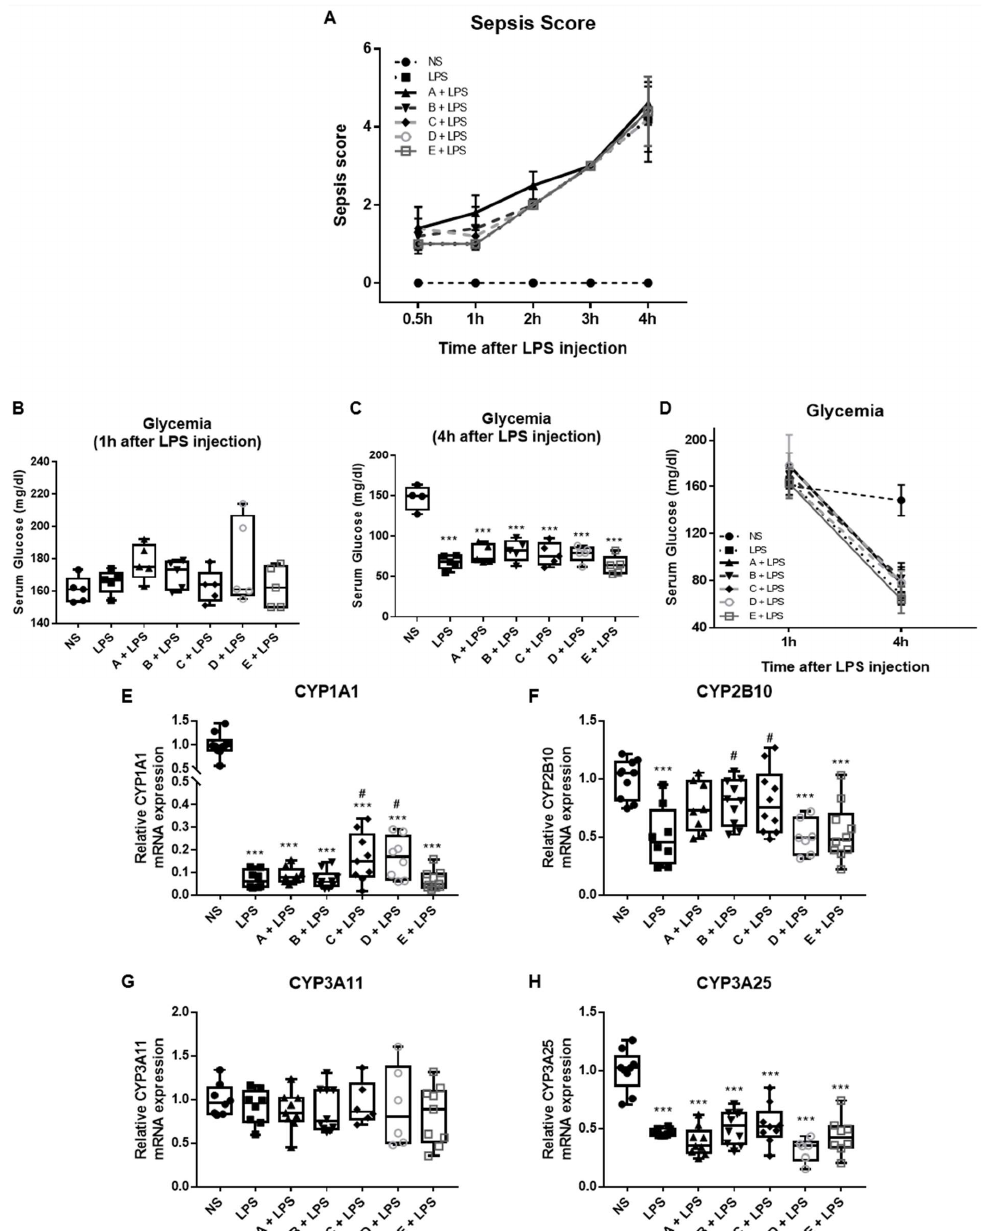
Figure 2. Effect of the Greek honey samples on the severity of LPS-induced endotoxemia: ( A ) severity score of LPS-induced sepsis; ( B – D ) serum glucose levels at 1 and 4 h after LPS challenge; liver mRNA expression of ( E ) CYP1A1, ( F ) CYP2B10, ( G ) CYP3A11, and ( H ) CYP3A25. All graphs represent measurements from 5 mice per group; the horizontal line in the box plots represents the median, and the whiskers represent the minimum and maximum. In the post-hoc test, the normal saline-treated group (NS) was selected as the control group for multiple comparisons with the LPS-injected groups: *** p < 0.001. The NS- vs. the LPS-injected groups or the LPS group was selected as the control group for multiple comparisons with the honey-treated groups: # p < 0.05, honey-treated group + LPS vs. LPS control group . The absence of an asterisk or hash indicates no statistical significance. A: Epirus arbutus; B: Evros chestnut; C: Epirus fir; D: Crete fir; E: Manuka honey. Clinical scoring system: 0 = no abnormal clinical signs; 1 = ruffled fur but lively; 2 = ruffled fur, moving slowly, hunched, and sick; 3 = ruffled fur, squeezed eyes, hardly moving, down, and very sick; 4 = same as 3 but with incontinence; 5 = moribund.